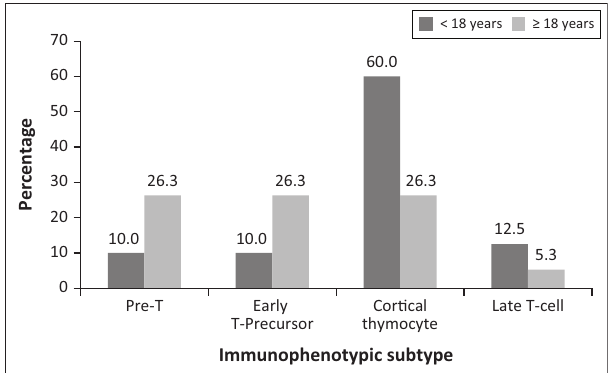
FIG URE 1: The distribution of immunophenotypic subtypes in T-cell lymphoblastic leukaemia according to age categories, presented as a percentage of cases in each age